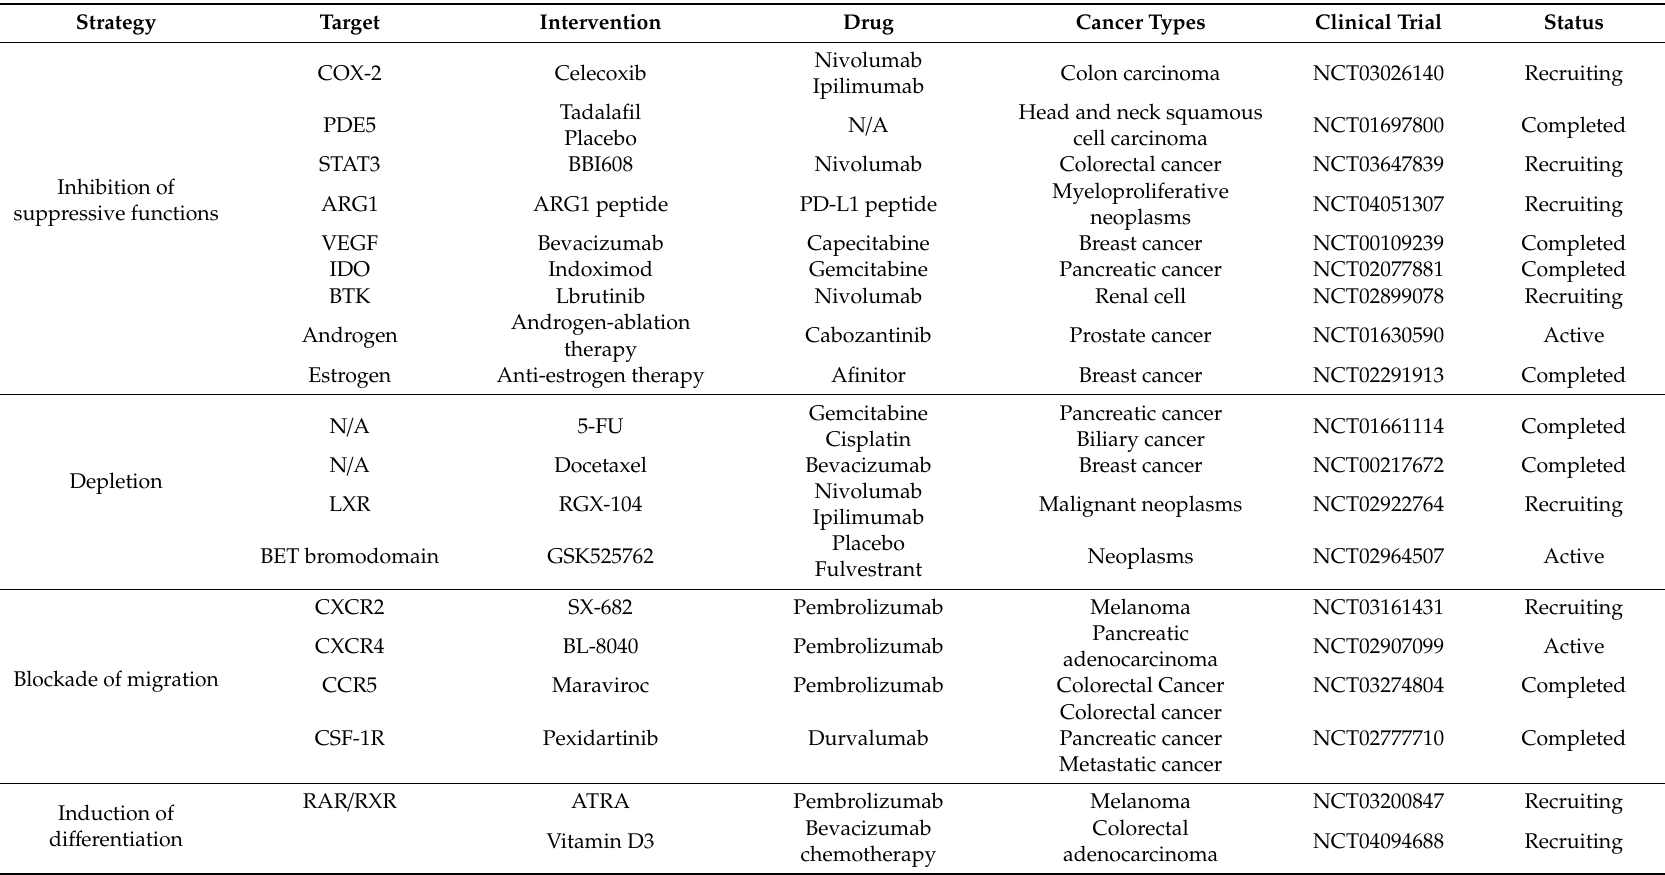
Table 1. Clinical trials of the regulation of